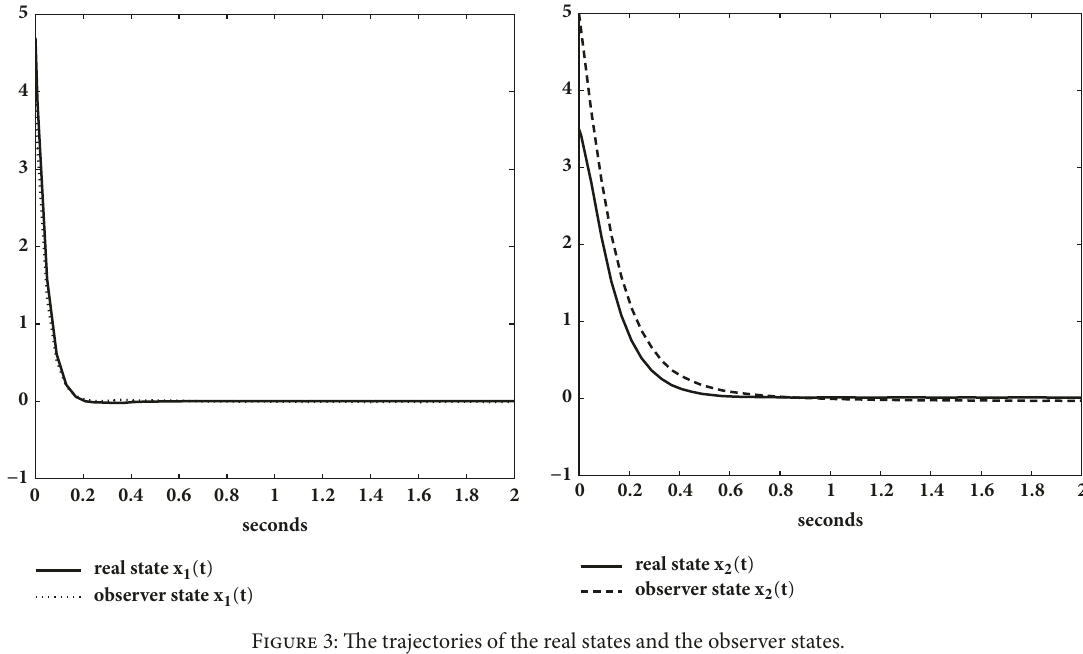
Figure 3: The trajectories of the real states and the observer states.